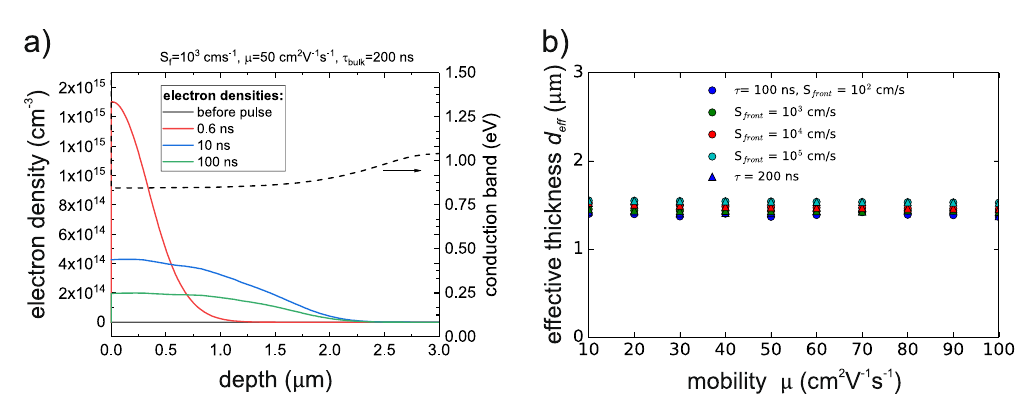
Figure 5. ( a ) TCAD simulations of the electron density within the back graded absorber bg-CIGS for different times after the excitation pulse. The back grading results in a decreased electron density towards the back confining the electrons within an effective depth d . ( b ) Calculated effective thickness for the back graded eff CIGS absorber according to Equations (7) and (11) with the same parameters τ bulk , S front , μ as used by the TCAD